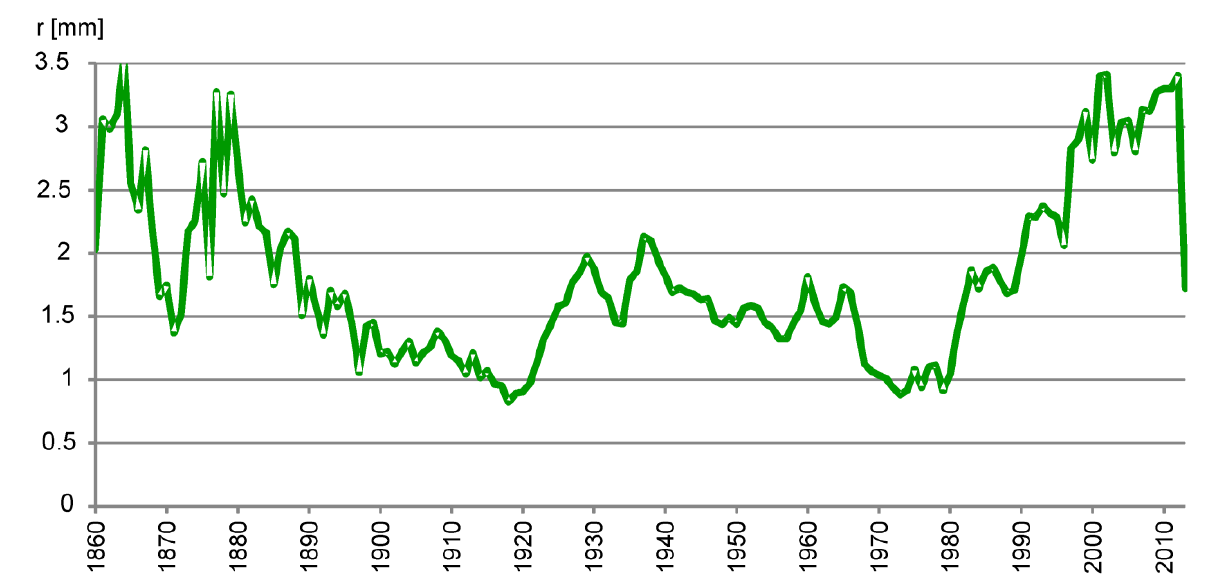
Fig. 4. Average tree-ring widths of silver firs sampled at the study